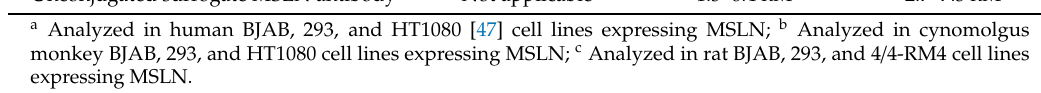
Table 1. Binding a ffi nity determined by radiolabeled equilibrium assays using di ff erent cell lines. Human Cynomolgus Monkey Rat Unconjugated lead MSLN antibody No binding No